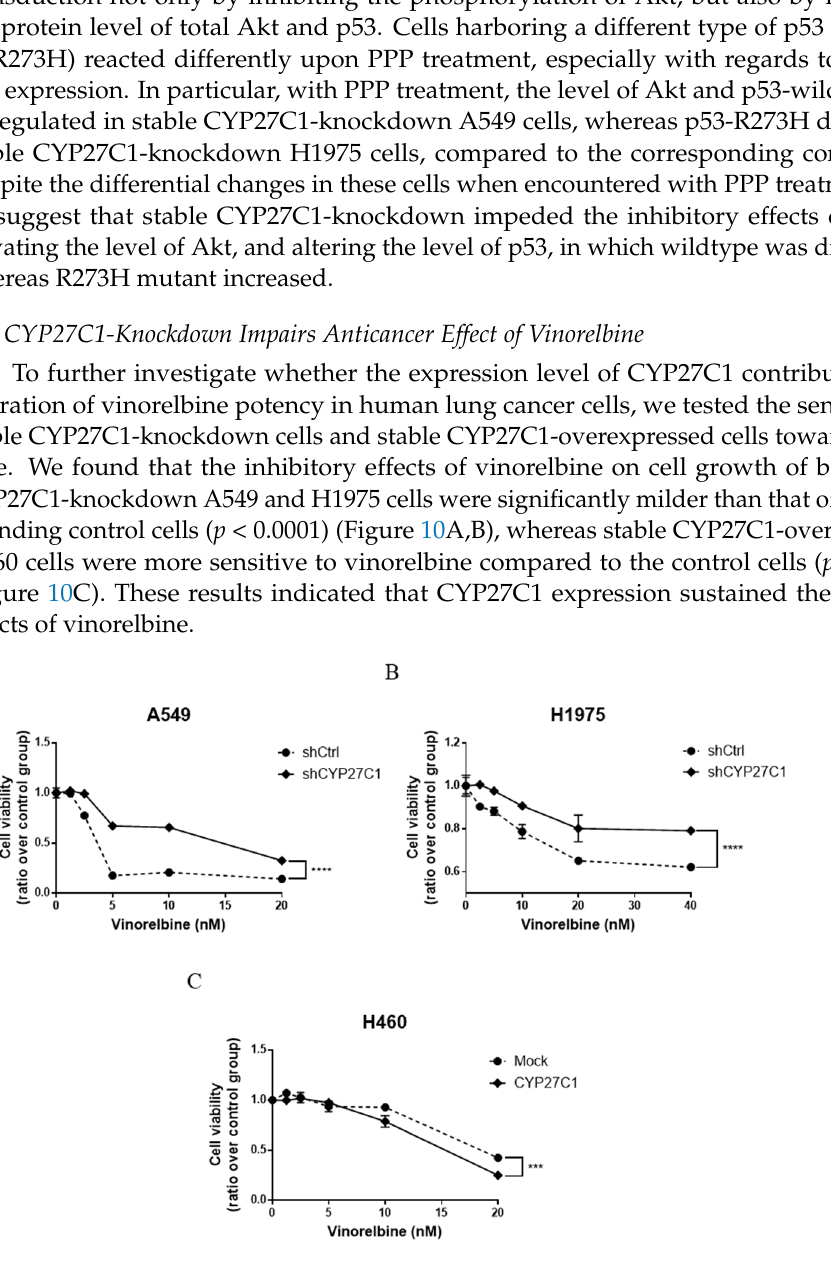
Figure 10. CYP27C1-knockdown impairs anticancer effect of vinorelbine. ( A – C ) A549-shCYP27C1, H1975-shCYP27C1, H460-CYP27C1, and the corresponding control cells were seeded in 24-well plates, respectively. After seeding for 24 h, cell medium was changed into that containing different concentrations of vinorelbine (0, 1.25, 2.5, 5, 10, 20 nM or 0, 2.5, 5, 10, 20, 40 nM). After treatment for 72 h, NBB assays were performed to detect cell viability. Results were analyzed by two-way ANOVA. ****, p < 0.0001, ***, p < 0.001.